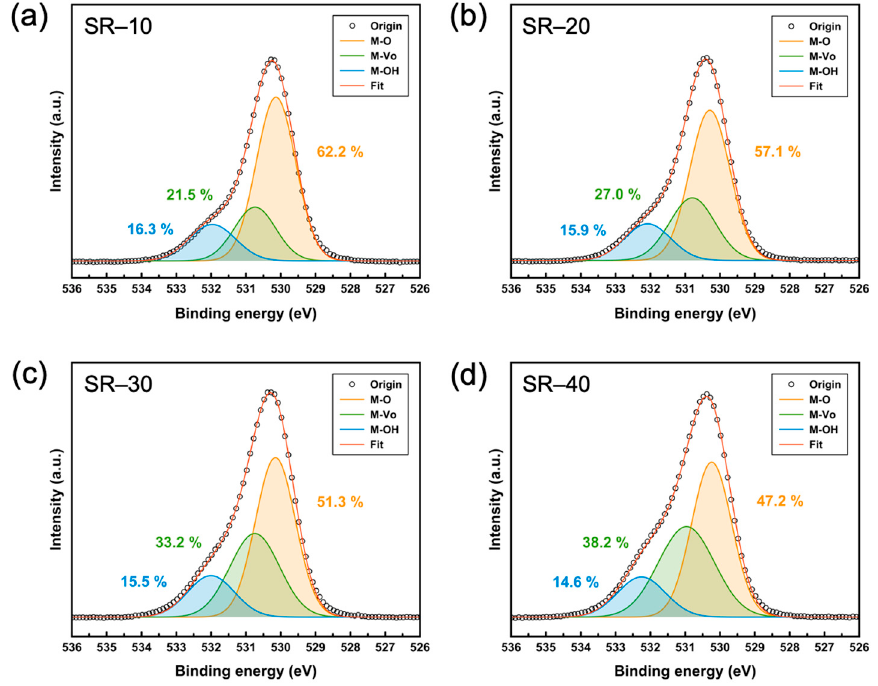
Figure 2. XPS O 1s spectra for ( a ) SR-10, ( b ) SR-20, ( c ) SR-30, and ( d ) SR-40.